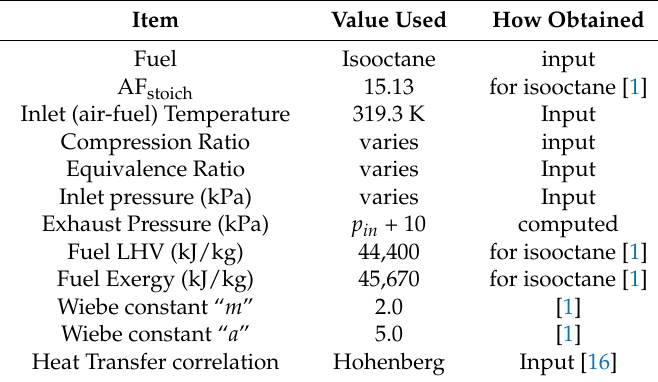
Table 2. Common Engine and Fuel Input